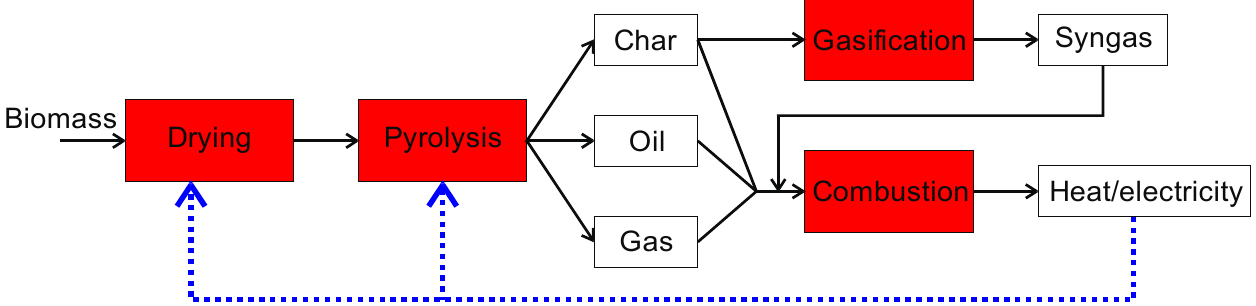
Figure 16. Heat production in thermochemical processes.